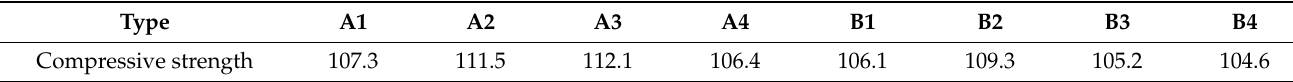
Table 2. 28 d compressive strength of UHPC (MPa).